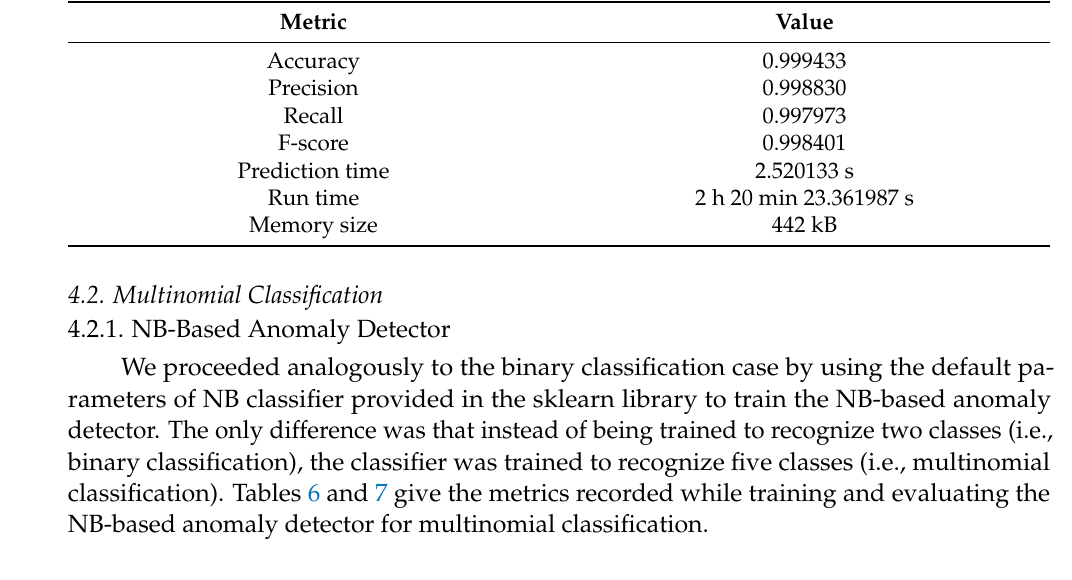
Figure 7. Training and validation loss of the deep ANN (binary classification). Table 5. Deep ANN-based anomaly detector’s metrics recorded (binary